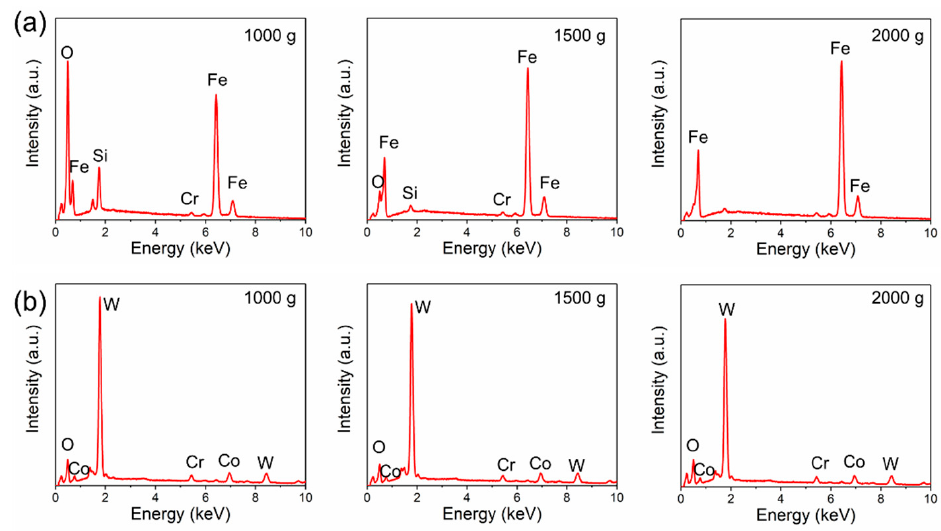
Figure 12. The morphologies of the wear surface of the ( a ) 27CrMoV substrate and ( b ) WC–10Co4Cr coatings after friction test at different loads.